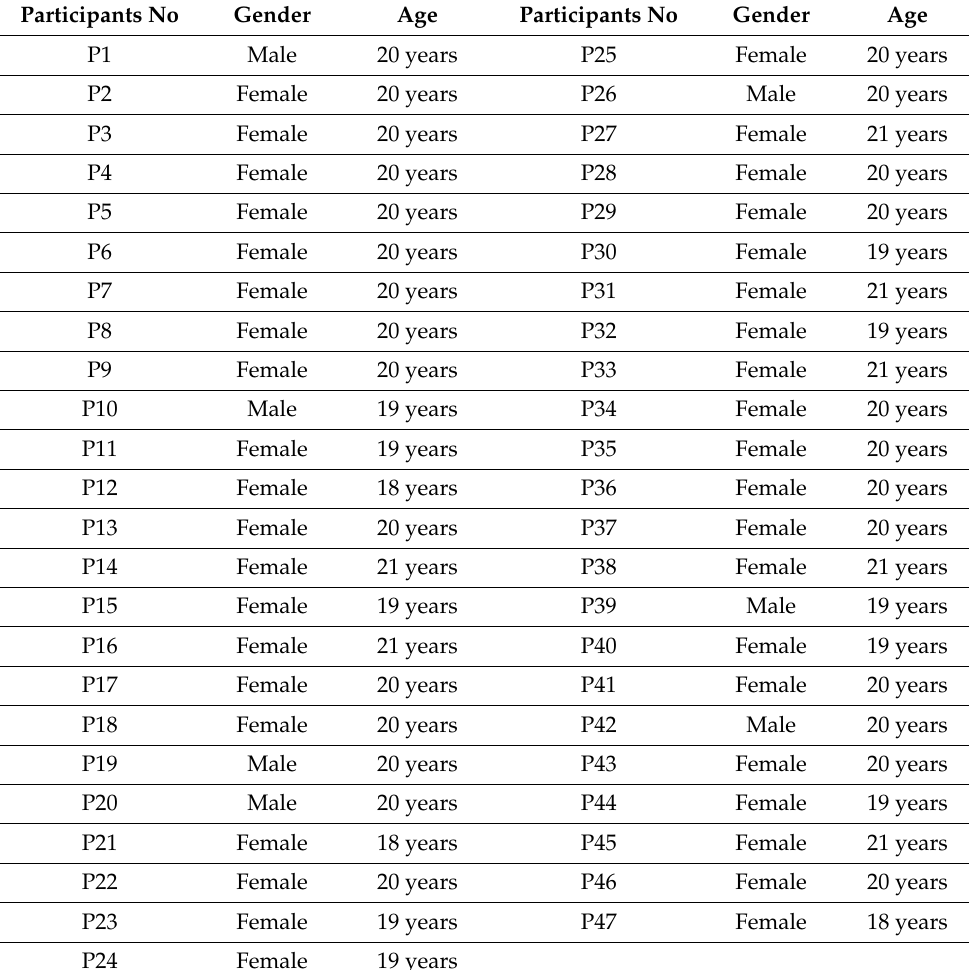
Table 1. Students’ characteristics ( n =